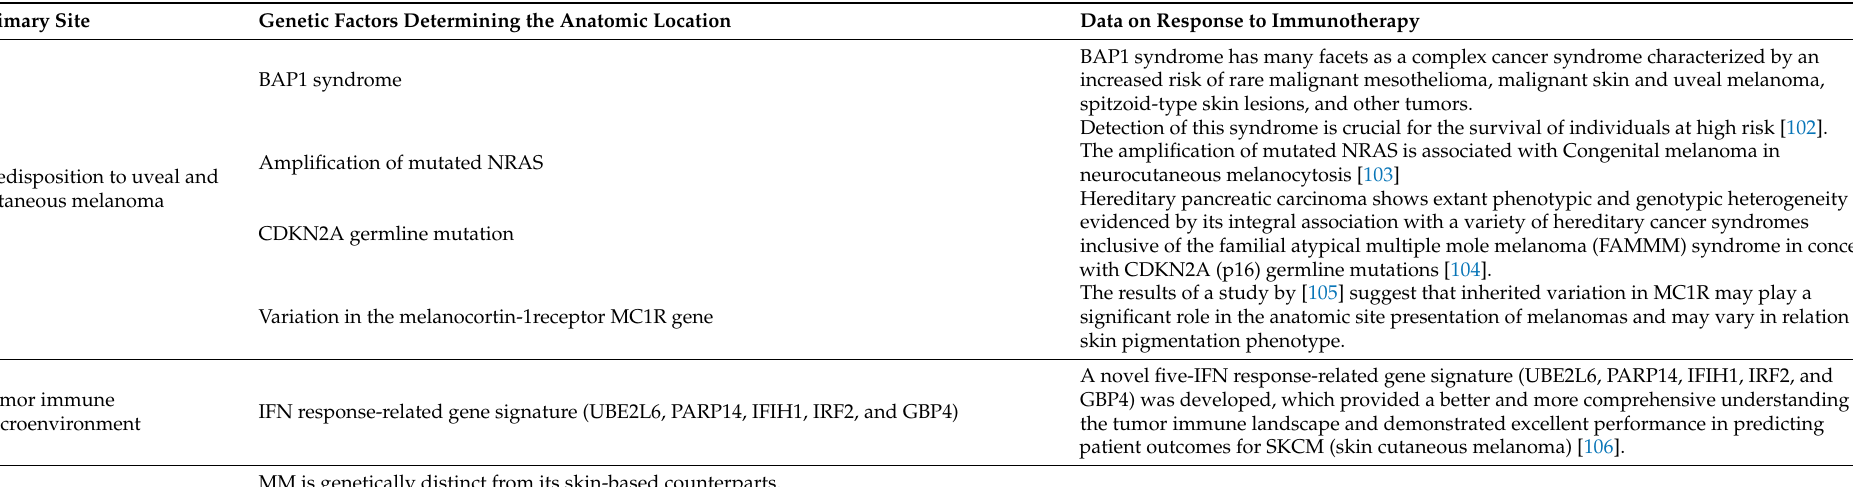
Table 3. The anatomical site, genes involved, and response to